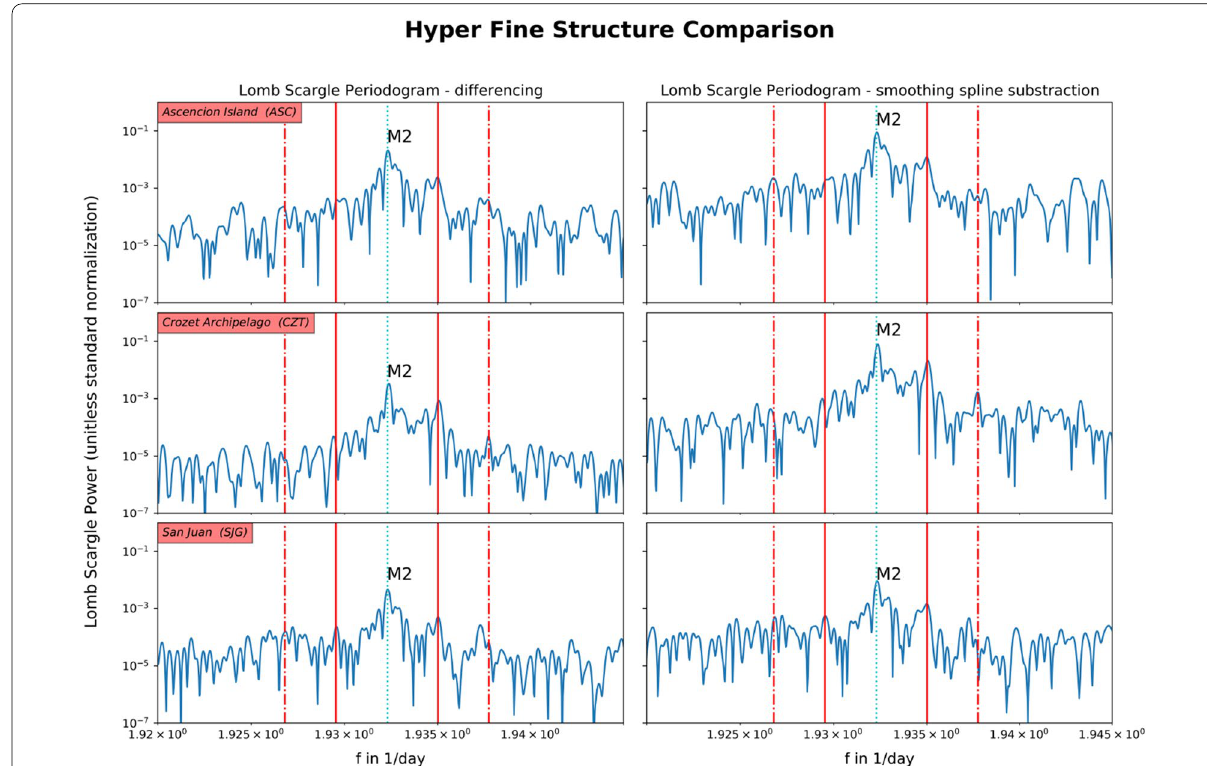
Fig. 2 Comparison of highly resolved periodograms of the M2 TODS peaks at all three analyzed Intermagnet stations ASC (top row), CZT (middle row) and SJG (bottom row). While the left column shows the spectra obtained after first order differencing, the right column shows the results after smoothing spline subtraction. The dotted blue lines mark the frequency of the diurnal principal lunar tide M2. Solid red lines mark side band frequencies associated with an annual variation (Sa) and red dot–dash lines mark side band frequencies associated with a semiannual variation (Ssa). When comparing the left and the right column, we find the hpyerfine structure around the M2 TODS peaks to be independent of the method used for trend